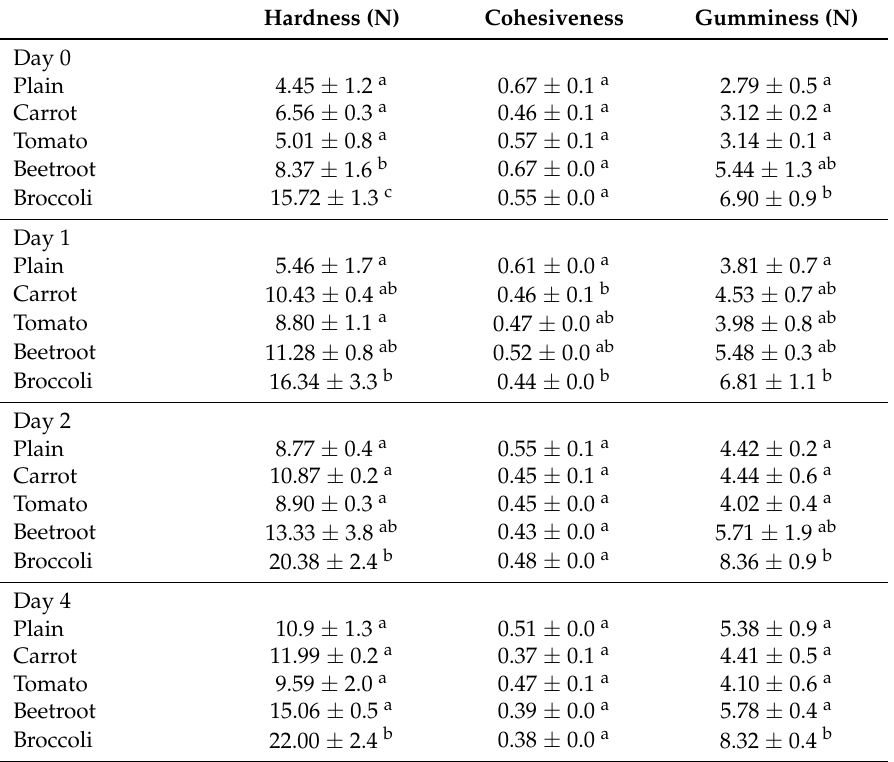
Table 2. Textural properties of the breads both while fresh and during